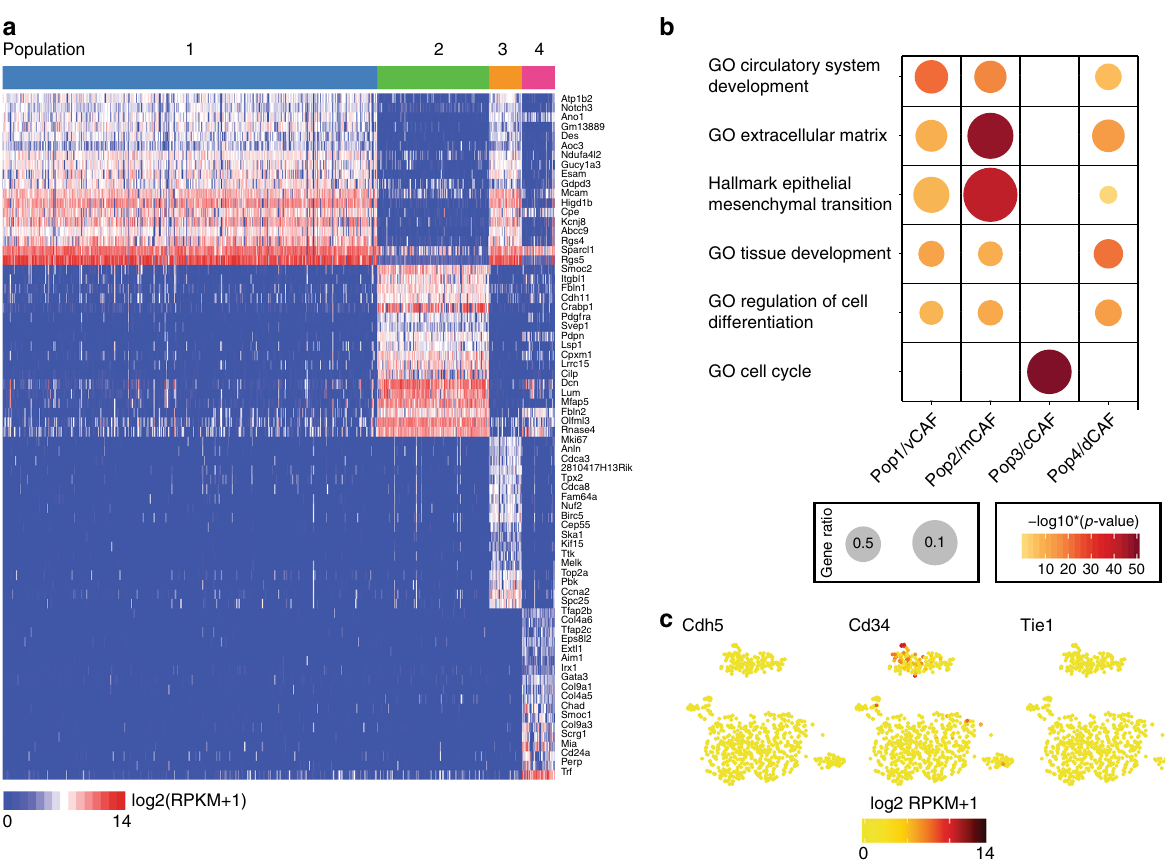
Fig. 2 Distinct gene pro fi les in CAF subpopulations account for functional differences. a Heatmap of top 18 differentially expressed genes in each subpopulation estimated by ROTS. b Enrichment of the 150 most SDE in gene ontology (GO) terms. Gene ratio is determined by the number of detected genes within a GO term compared to the total number of genes. c Expression plots based on t -SNE layout. log 2 (RPKM + 1) levels of endothelial cell genes in individual